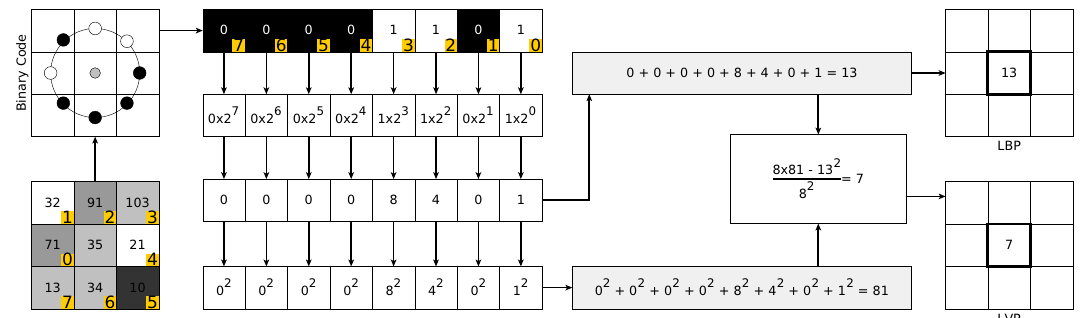
Figure 18. Pattern extraction process for a given pixel using LBP and LVP descriptors with R = 1, P = 8, t c = 35, and t p = { 71,32,91,103,21,10,34,13 }